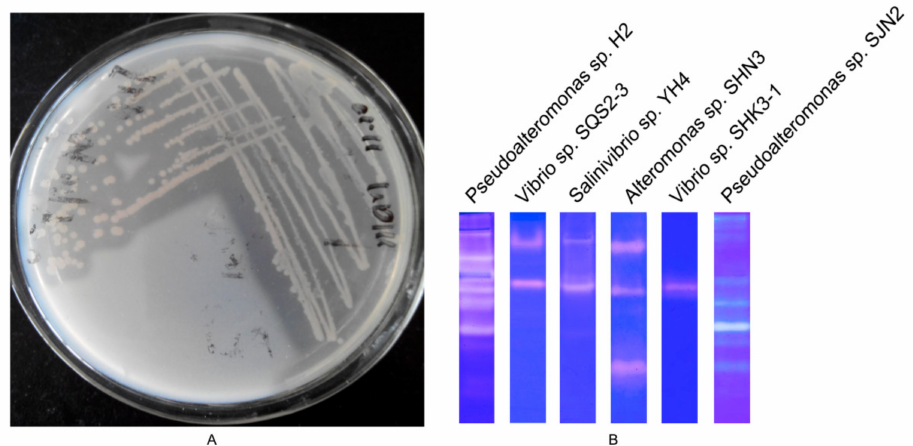
Figure 1. Screening of Pseudoalteromonas sp. H2. ( A ). Formation of clear zones on a casein plate of strain H2. ( B ). Comparison of the caseinolytic profile from Pseudoalteromonas sp. H2, Vibrio sp. SQS2-3, Salinivibrio sp. YH4, Alteromonas sp. SHN3, Vibrio sp. SHK3-1, and Pseudoalteromonas sp. SJN2.